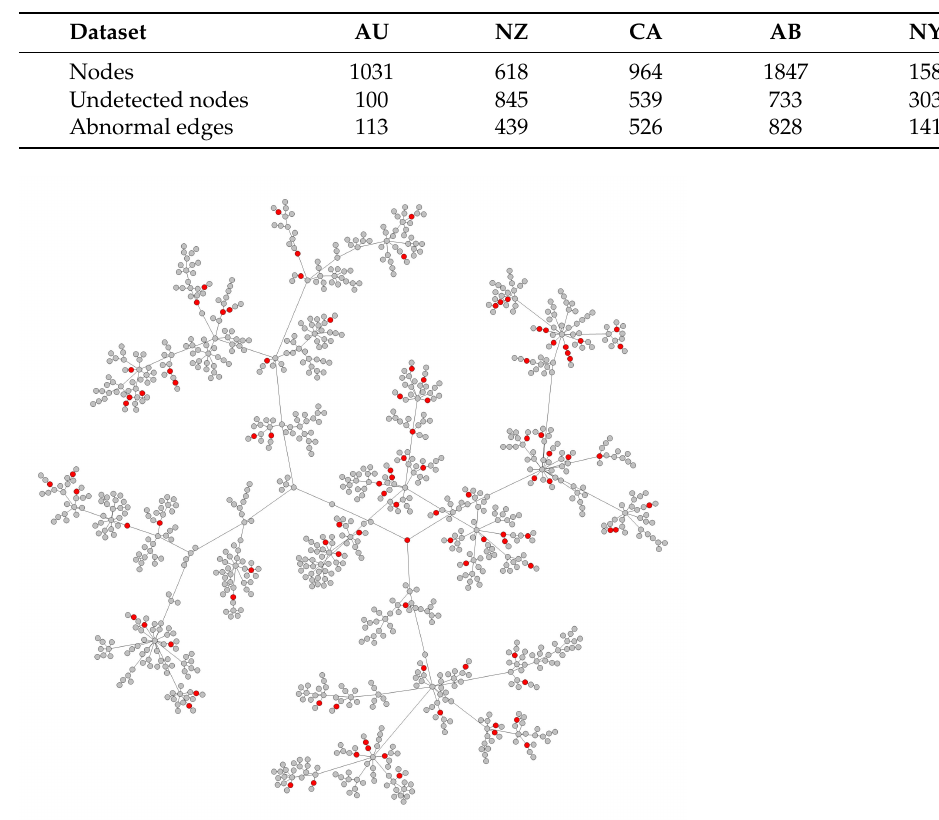
Figure 7. The inferred Australia transmission network, the red nodes are inferred undetected infections in